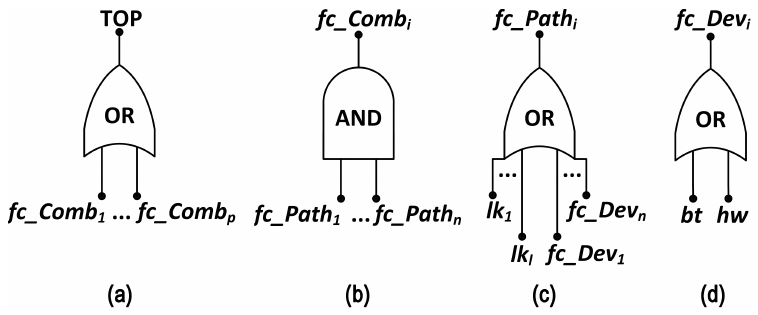
Figure 6. Fault Tree models of ( a ) network, ( b ) combinations, ( c ) paths and ( d ) devices